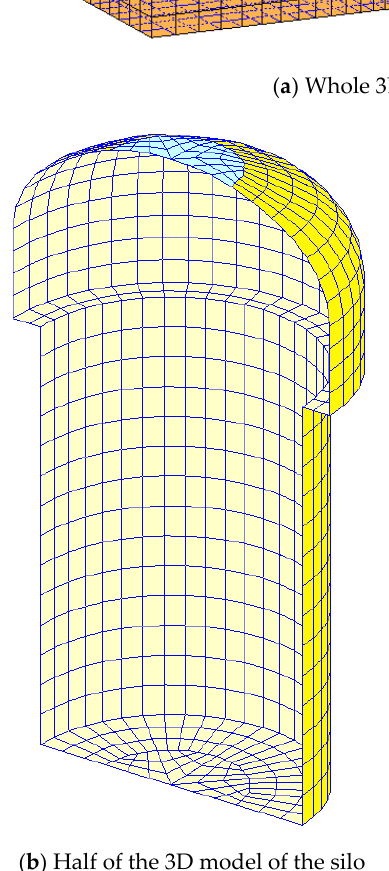
Figure 9 . 3D finite element model of the underground silo. Figure 9. 3D finite element model of the underground